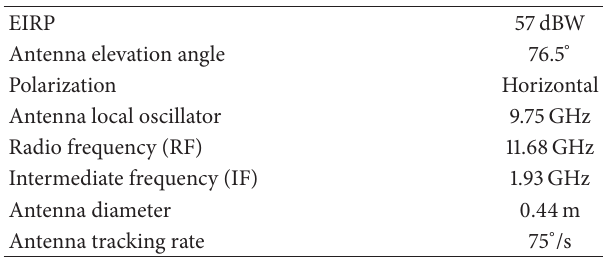
Table 2: LMS system parameters.